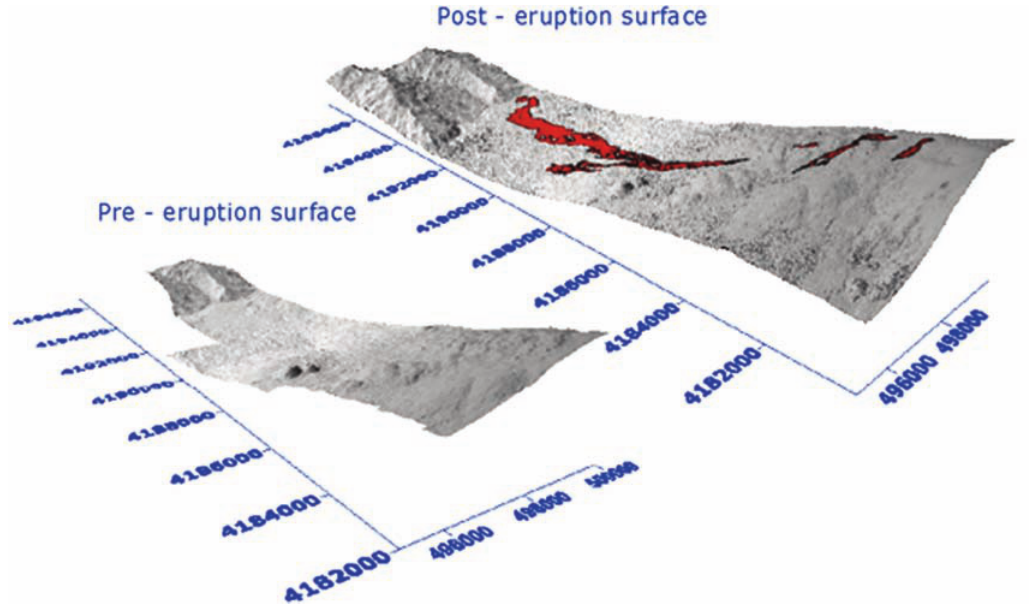
Figure 3. Pre-eruption (left) and post-eruption (right) surfaces of the 1981 Etna eruption, with the lava flow fields superimposed in red on the post- eruption